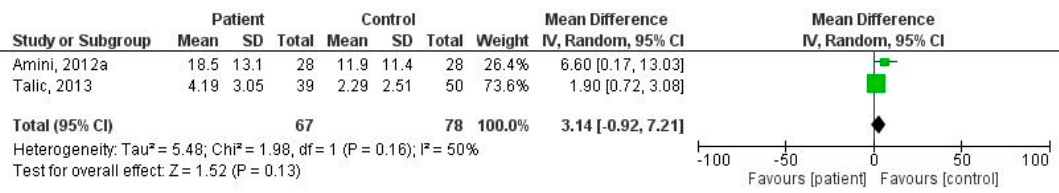
Figure 6. Forest plot of the random effect of salivary chromium levels in patients under fixed orthodontic treatment in case-control studies. 3.3.3. Quality Evaluation Table 3 shows the quality score for each study included in the meta-analysis. The mean score was 7.78 for cross-sectional, 6.67 for cohort, and 7.50 for case-control studies. Table 3. Quality ratings for the studies included on the basis of Newcastle–Ottawa quality assessment scale (n = 14). First author, publication year